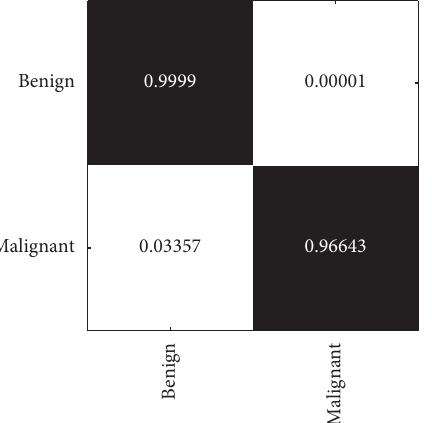
Figure 5: The optimal confusion matrix of